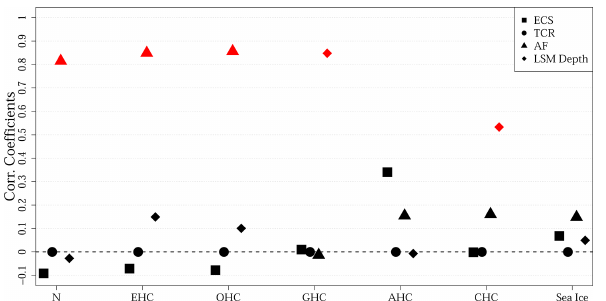
Figure 6. Correlation coefficients between the simulated equi- librium climate sensitivity (ECS, squares), transient climate re- sponse (TCR, circles), adjusted forcing (AF, triangles), depth of the LSM component (LSM depth, diamonds) and the components of the Earth heat inventory. Results obtained by analysing the 18 models presenting estimates of ECS, TCR and AF in Forster et al. (2013). Red symbols indicate statistically significant results at the 95% confidence level using a Student’s t test. The dashed black horizontal line indicates zero